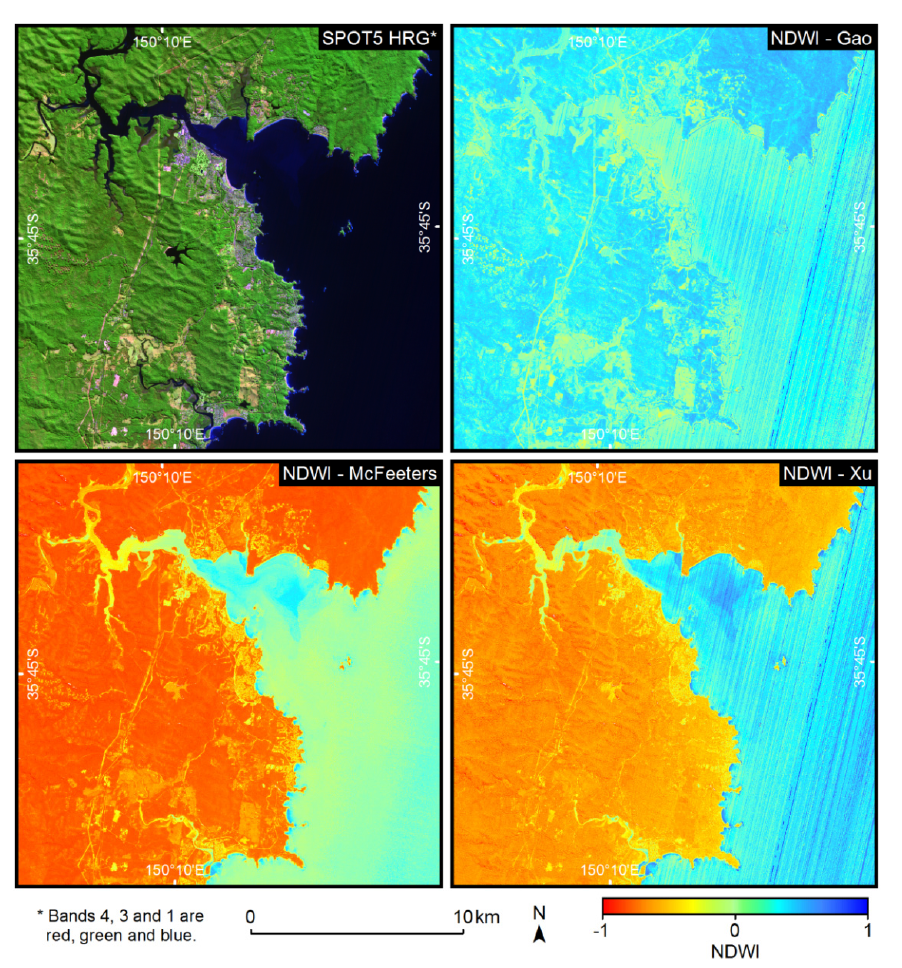
Figure 1. The three different versions of the normalized difference water index (NDWI) for a subset of a SPOT5 HRG image, over the coast of New South Wales,